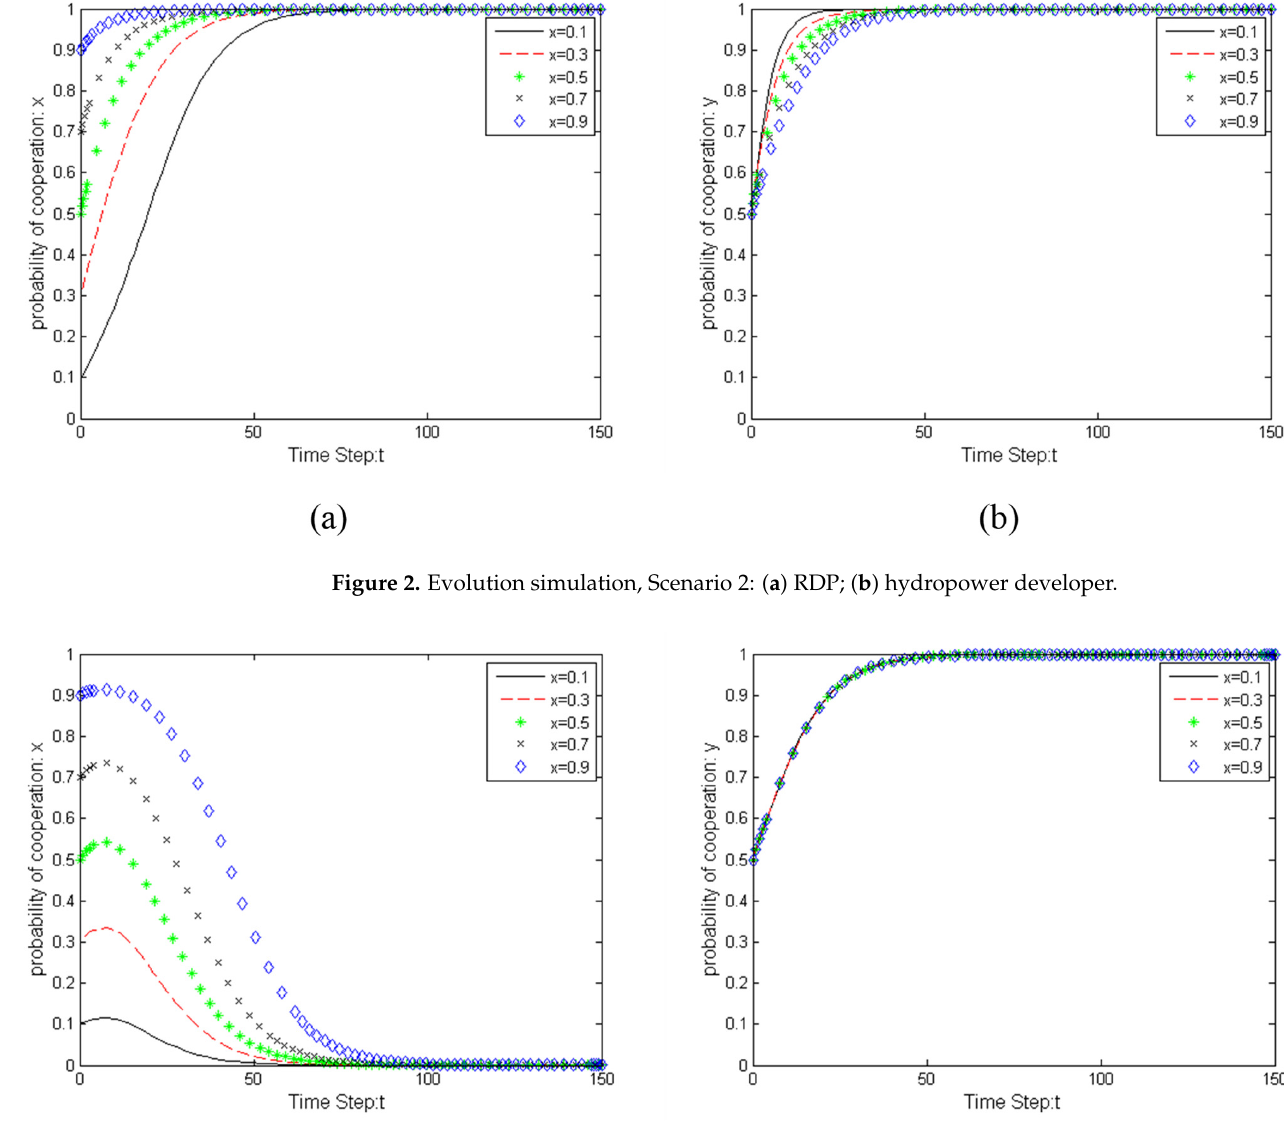
Figure 1. Evolution simulation, Scenario 1: ( a ) RDP; ( b ) hydropower developer.